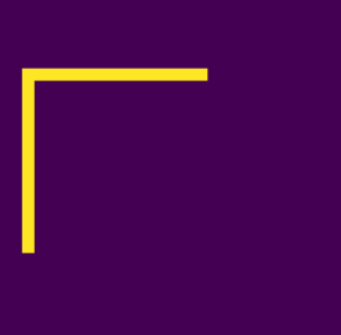
Figure 12. Moved.